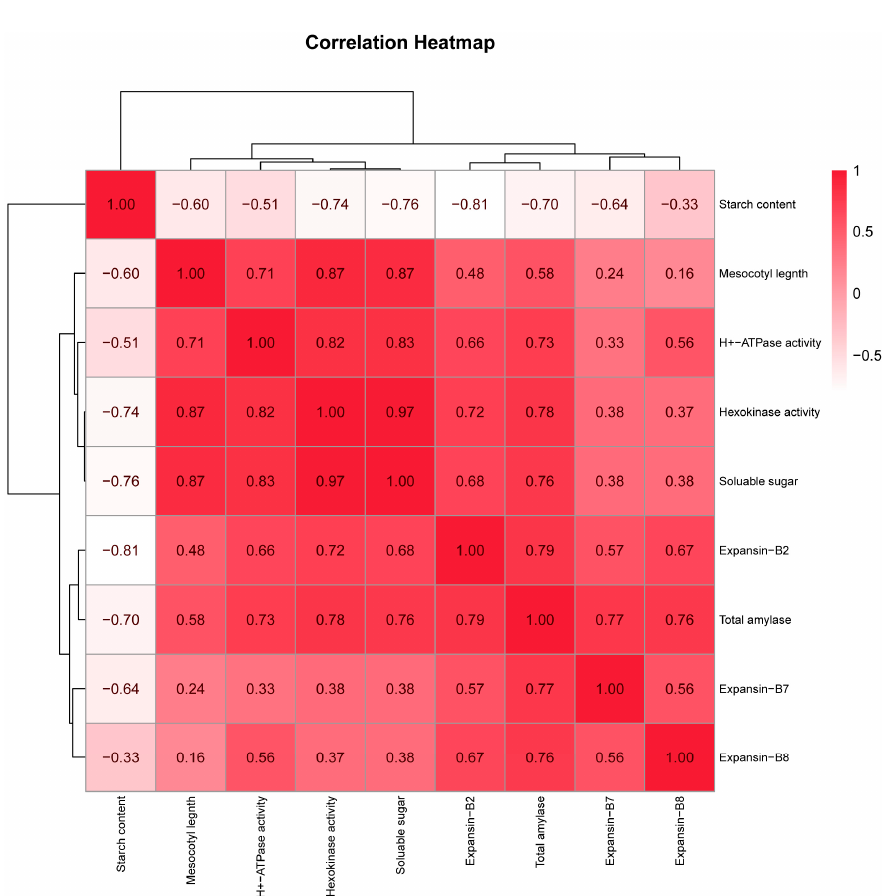
Figure 9. The correlation heatmap among characters measured in this study. The colors shown in the color bars, gradually from red to white, present the correlation between the two characters from high to low, respectively.